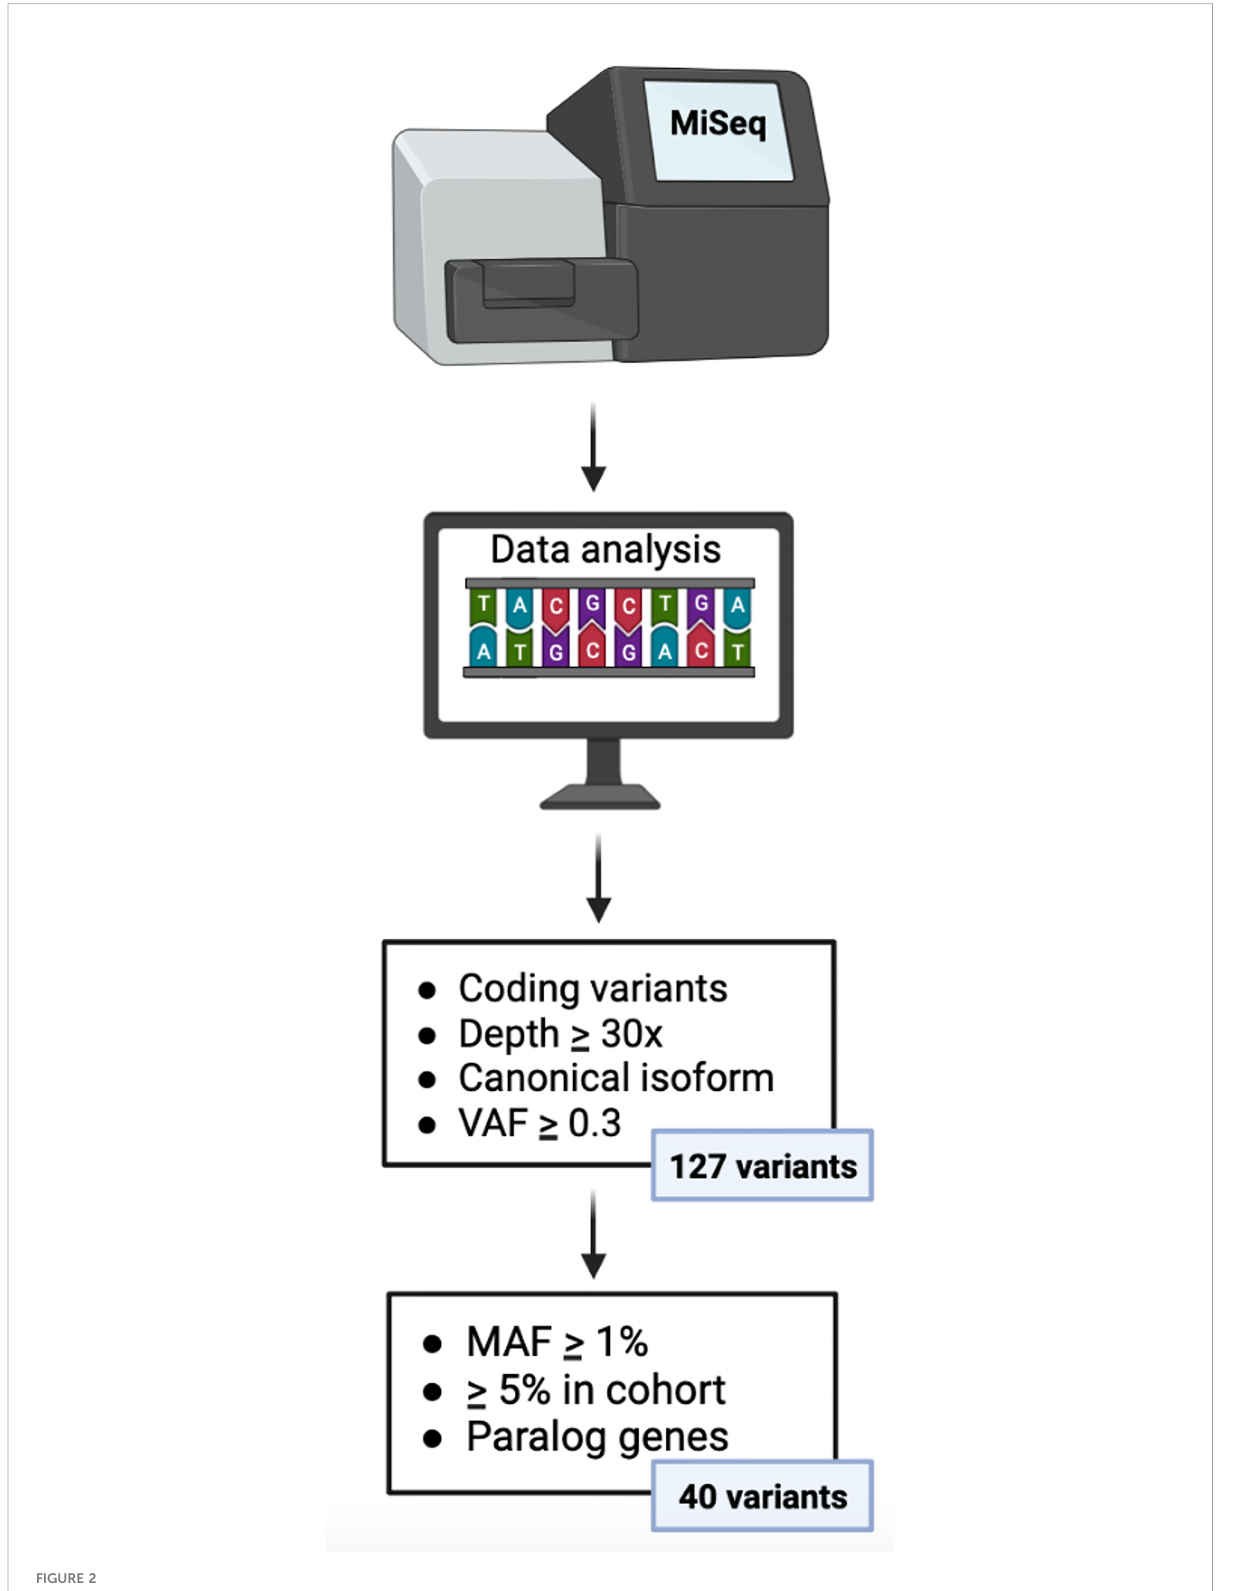
FIGURE 2 Algorithm for gene variant fi ltration. VAF, variant allele frequency; MAF, minor allele